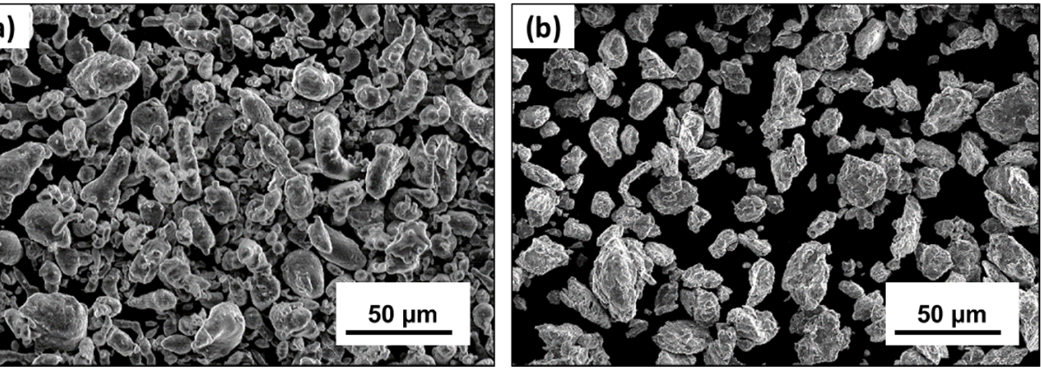
Figure 2. SEM images showing the surface morphology and structure of ( a ) Pure Al and ( b ) Pure Mg powders.